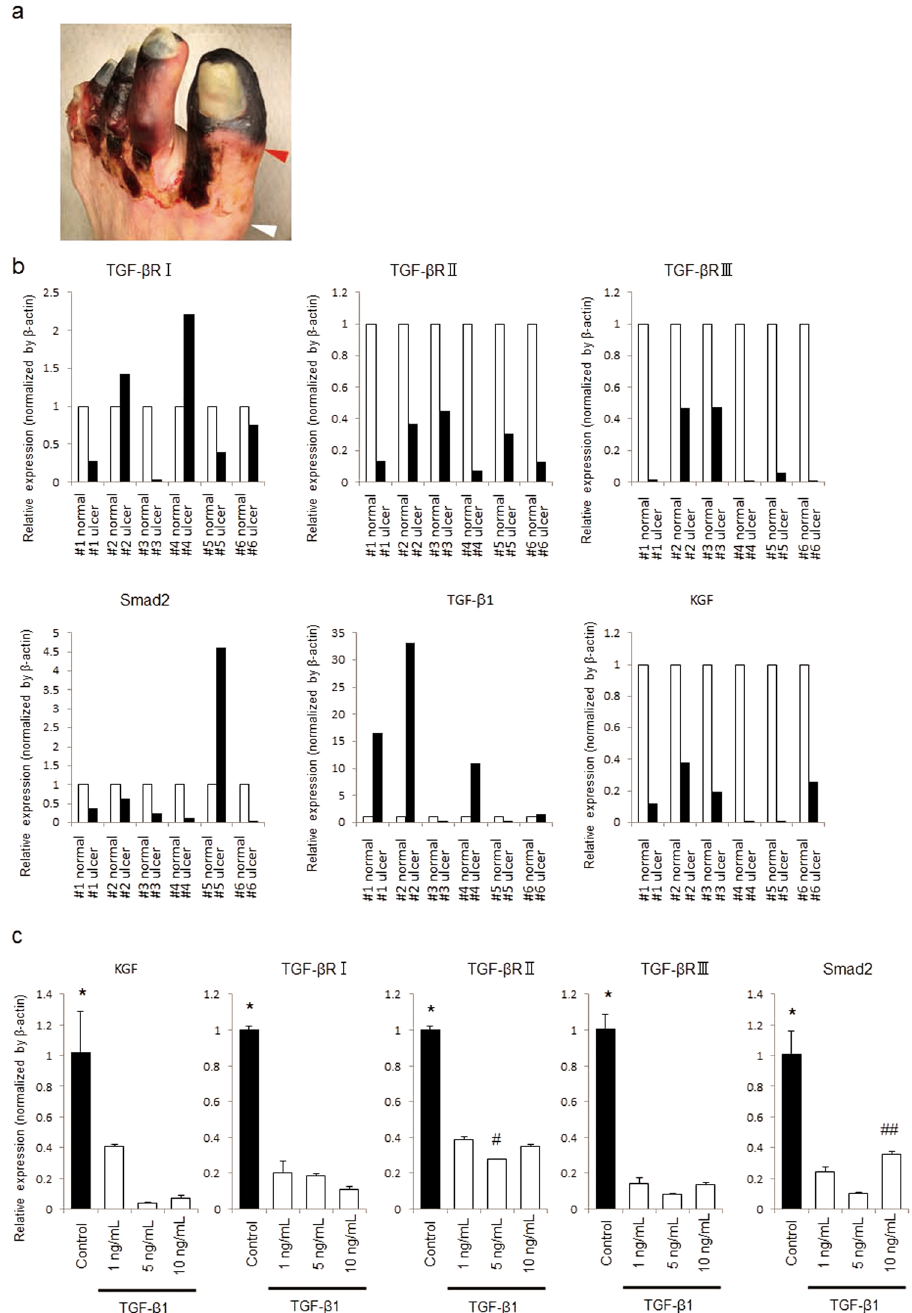
Figure 4. Characteristics of human ulcers caused by ischemia. ( a ) Images of the ischemic ulcer of patient 3. After amputation, the skin around the ulcer (red arrowheads) and the amputated stump as a control (white arrowheads) was collected. ( b ) Levels of mRNAs encoding TGF- β RI, TGF- β RII, TGF- β RIII, SMAD2, TGF- β 1, and KGF were analyzed using qPCR with ACTB as an endogenous control and are presented relative to those of normal skin. ( c ) Recombinant TGF- β 1 reduced the levels of mRNA encoding KGF, TGF- β RI, TGF- β RII, TGF- β RIII, and SMAD2 in human fibroblasts. Values are expressed as mean ± SD. * P < 0.01 vs all samples, # P < 0.01 vs 1 ng/mL and 10 ng/mL, ## P < 0.05 vs 5